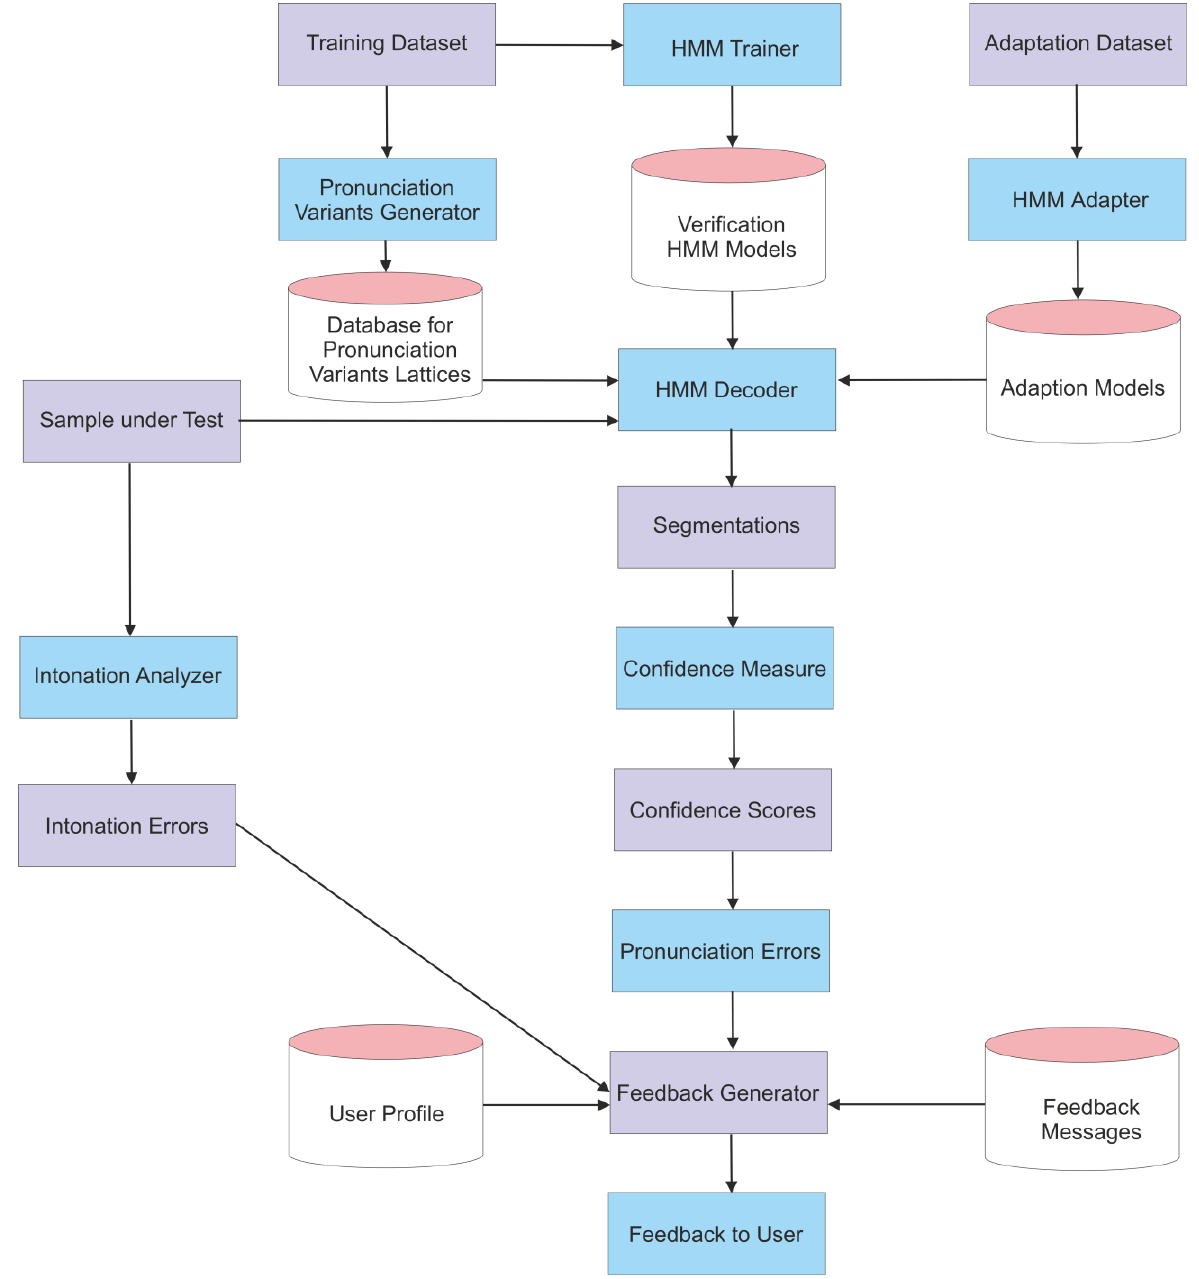
Figure 2. The Speak Correct system architecture .